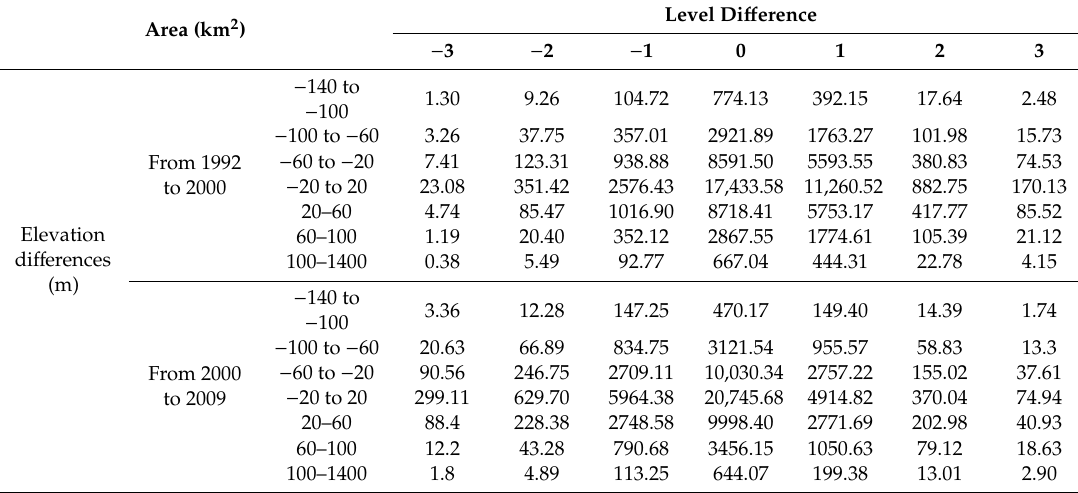
Table 7. Numbers of historical landslide events at various assessment levels from 1992 to 2000 and from 2000 to